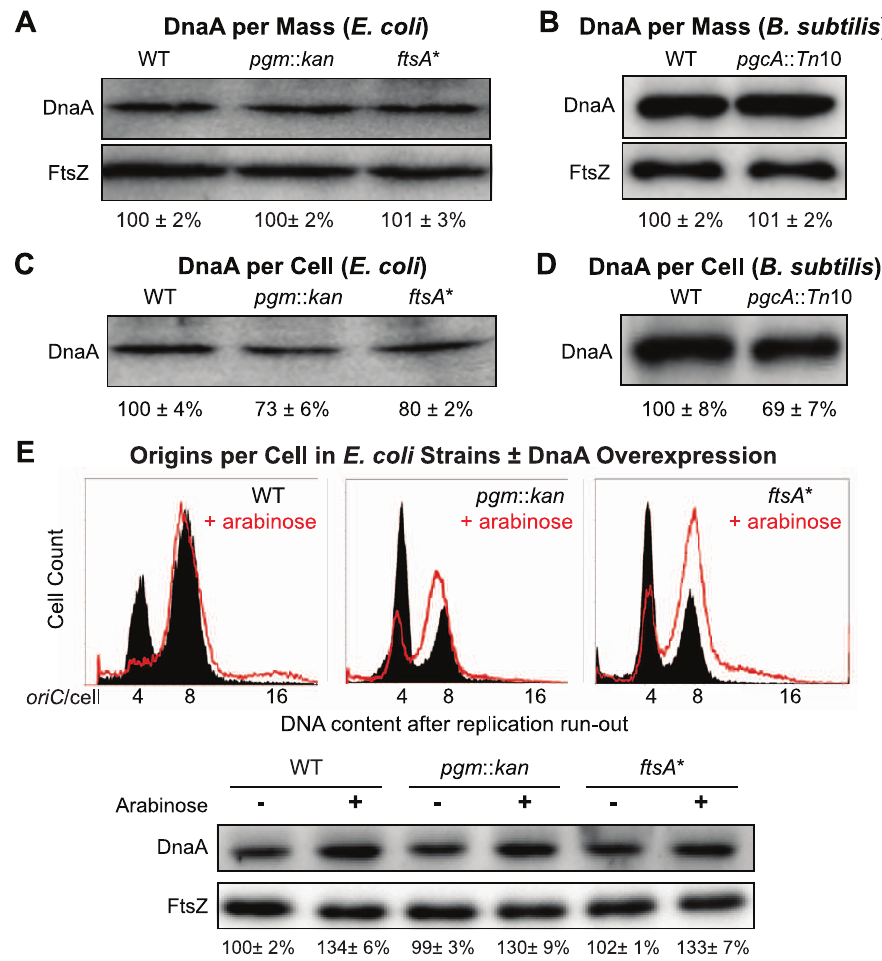
Figure 4. Fewer DnaA molecules in small E.coli and B.subtilis mutants. (A & B) Quantitative immunoblot of DnaA levels in E. coli and B. subtilis grown in LB. Gel loading was normalized to optical density. FtsZ serves as loading control. (C & D) Relative DnaA levels per cell. Gel loading was normalized to cell number (see Materials and Methods). Note that while DnaA concentration is wild type in the mutant strains (A & B), DnaA per cell is lower in the mutants (C & D). Error equals one standard deviation (n=3). (E) Representative plots of DNA content post replication run-out of the E. coli strains with a plasmid encoding an arabinose inducible allele of dnaA either uninduced (solid black) or induced (red line). Relative concentrations of DnaA are shown at the bottom by immunoblot. FtsZ was used as a loading